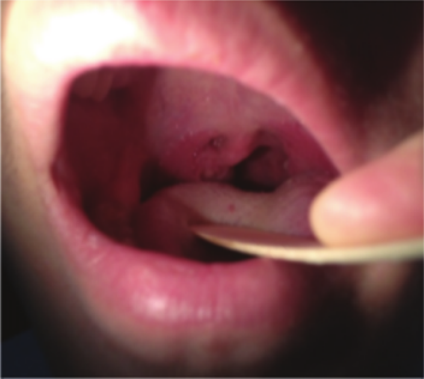
Figure 4: ENT evaluation after